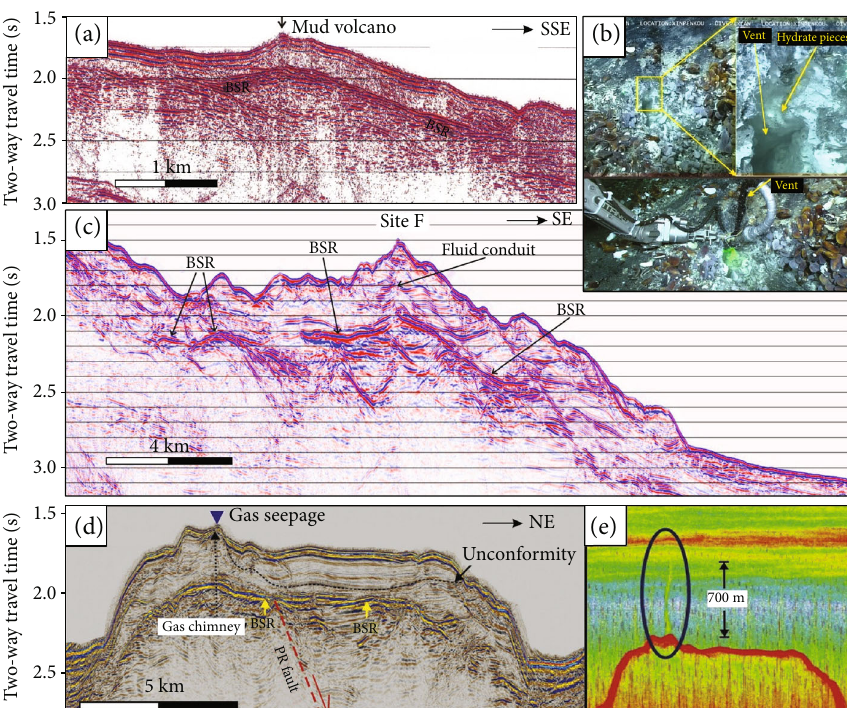
Figure 8: (a) Seismic pro fi le showing the BSRs observed in the vicinity of a mud volcano developed o ff shore of southwestern Taiwan (modi fi ed from Liu et al. [97]). (b) Cold seep vents and gas hydrates exposed on the sea fl oor at site F on the Formosa Ridge [47]. (c) Seismic pro fi le showing the gas seepage and BSRs crossing site F on the Formosa Ridge [124]. (d) Seismic pro fi le showing the gas seepage and BSRs on Pointer Ridge [126]. (e) Gas plume detected on Pointer Ridge [126]. Fault PR is the Pointer Ridge fault.